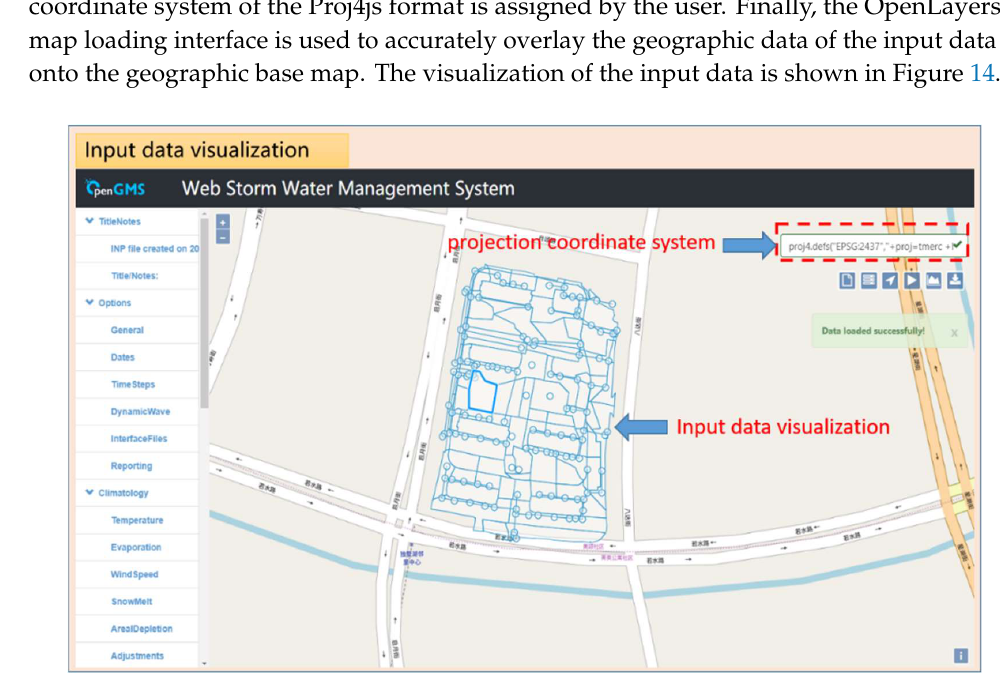
Figure 14. Input data visualization.